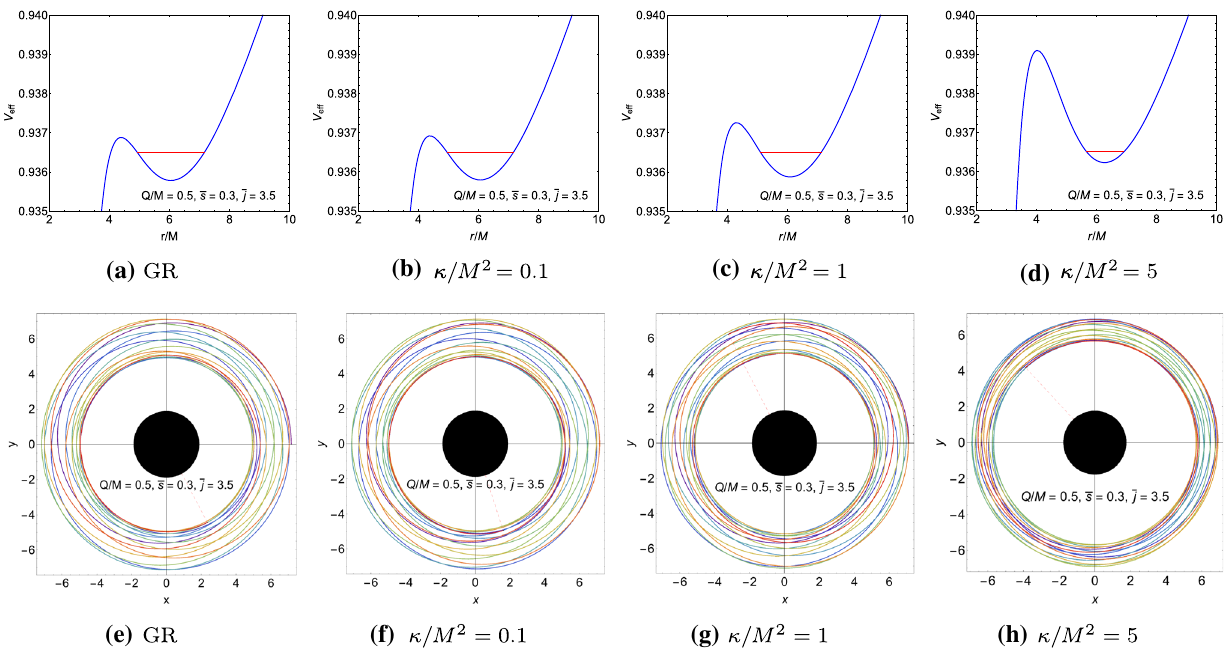
¯ e = 0 . 9365 are plotted in ( e , f ), where the dashed red lines indicate the terminal points of the trajectories at the end of the time interval, and the black discs represent the inner regions of black holes